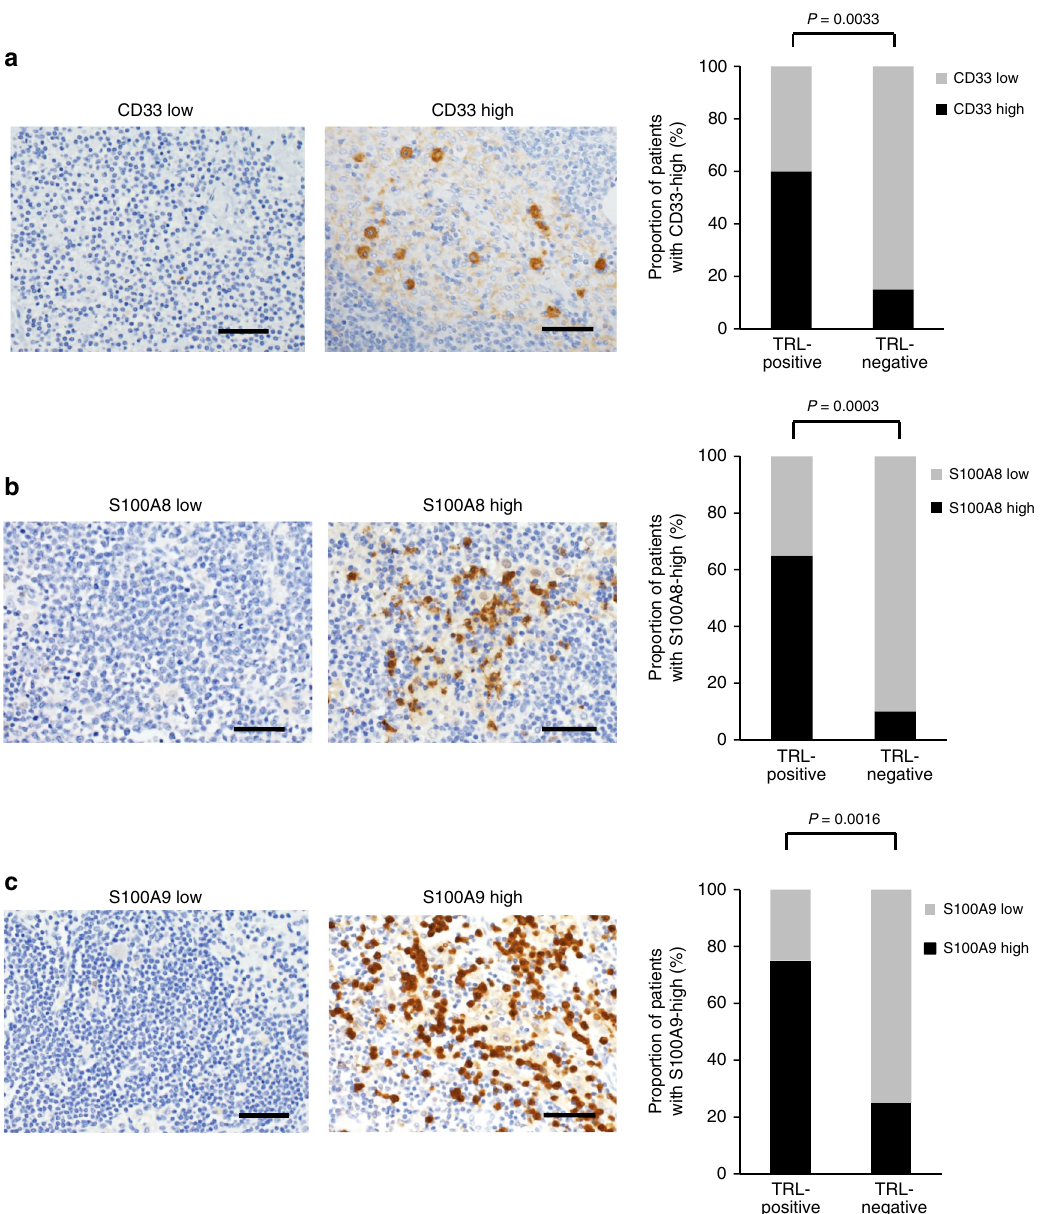
Fig. 5 Immunoreactivities of resected lymph nodes for CD33 and S100A8/9 in cervical cancer patients TRL-positive versus TRL-negative patients. a CD33 expression in cervical cancer patients according to white blood cell counts. Photographs; representative CD33-stained lymph node sections from cervical cancer patients. A graph; proportion of patients with CD33-high. b S100A8 expression in cervical cancer patients according to white blood cell counts. Photographs; representative S100A8-stained lymph node sections from cervical cancer patients. A graph; proportion of patients with S100A8-high. ( c ) S100A9 expression in cervical cancer patients according to white blood cell counts. Photographs; representative S100A9-stained lymph node sections from cervical cancer patients. A graph; proportion of patients with S100A9-high. Scale bars, 50 μ m. Statistical signi fi cance was assessed using two-sided Fisher ’ s exact test (TRL-positive: WBC ≥ 9000/mL, n = 20; TRL-negative: WBC < 9000/mL, n = 20). Source data are provided as a Source Data fi